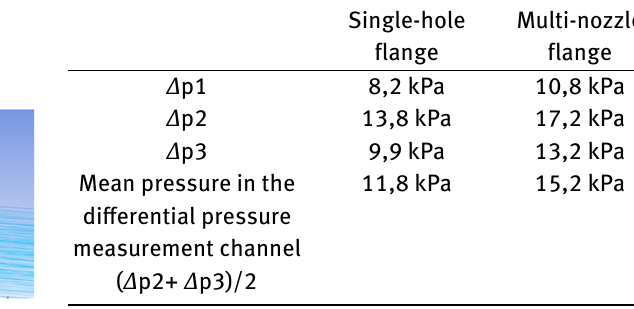
Bores (cid:31) 2 mm in the nut holding the orifice are used for measurement of the differential pressure. Pressure on the orifice hole edge was numerically calculated ( ∆ p1). In order to measure the pressure in the bores of the nut nec- essary is the to calculate the pressure on the edge closer to the orifice flange ( ∆ p2) and in the opposite side of the same bore ( ∆ p3).